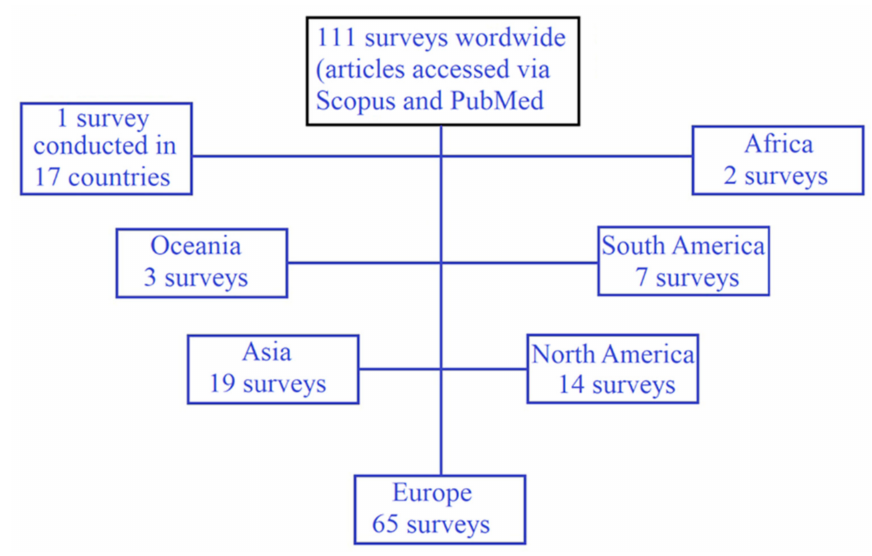
Figure 1. Distribution of surveys by continent (referring to COVID-19 consequences). A PRISMA flow diagram for this review is presented in Figure